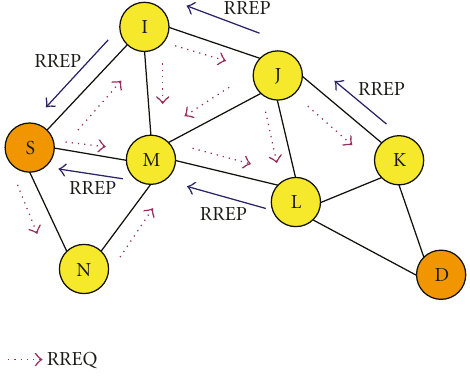
Figure 3: AODV Route Discovery